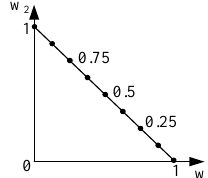
Fig. 7 The choice of weight